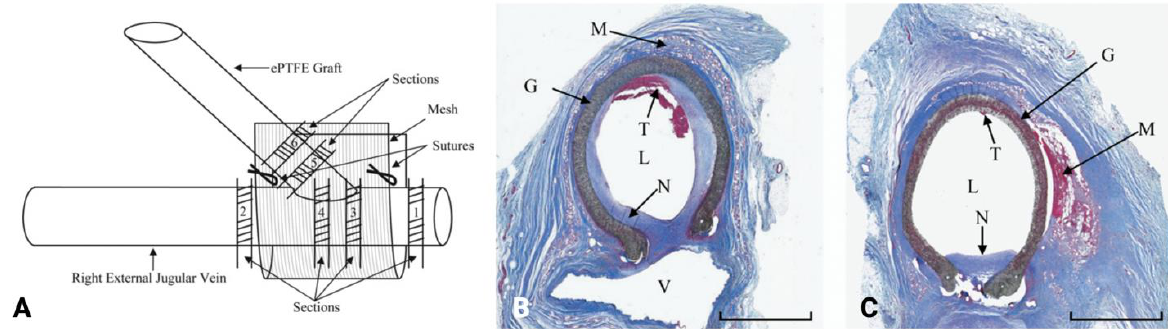
Figure 6 . ( A ) Schematic diagram of the right external jugular vein and ePTFE graft anastomosis with applied mesh and histologic sections. ( B , C ) Photomicrographs of representative sections from the zero-dose mesh control group ( B ) and the 1.2- μg/mm2 paclitaxel mesh group ( C ). G, ePTFE graft; L, lumen; M, mesh; N, neointima; T, thrombus; V, vein. Bars represent 4 mm. Images are